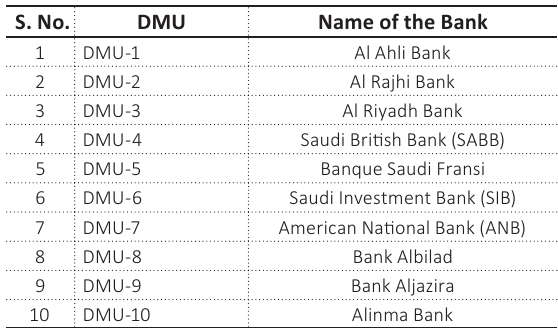
Table 1. List of Decision-Making Units (DMUs) selected for the